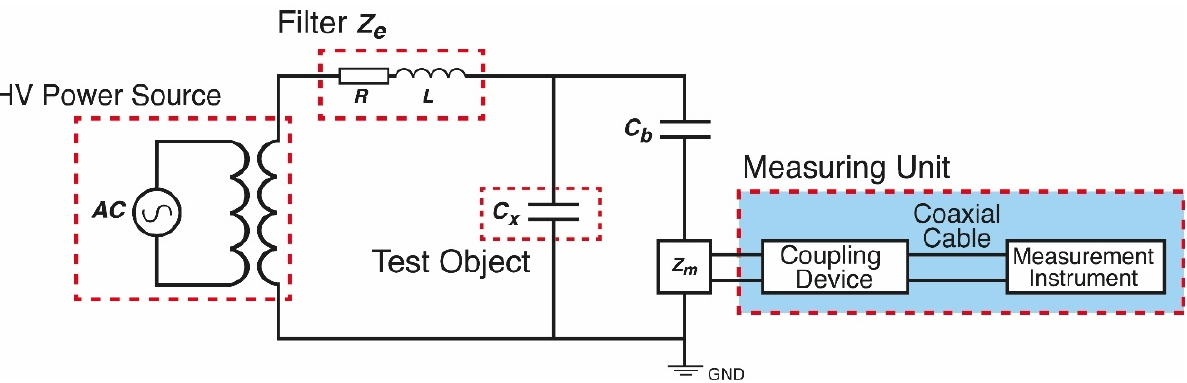
Figure 3. Electrical PD measuring circuit based on the IEC 60270 standard.